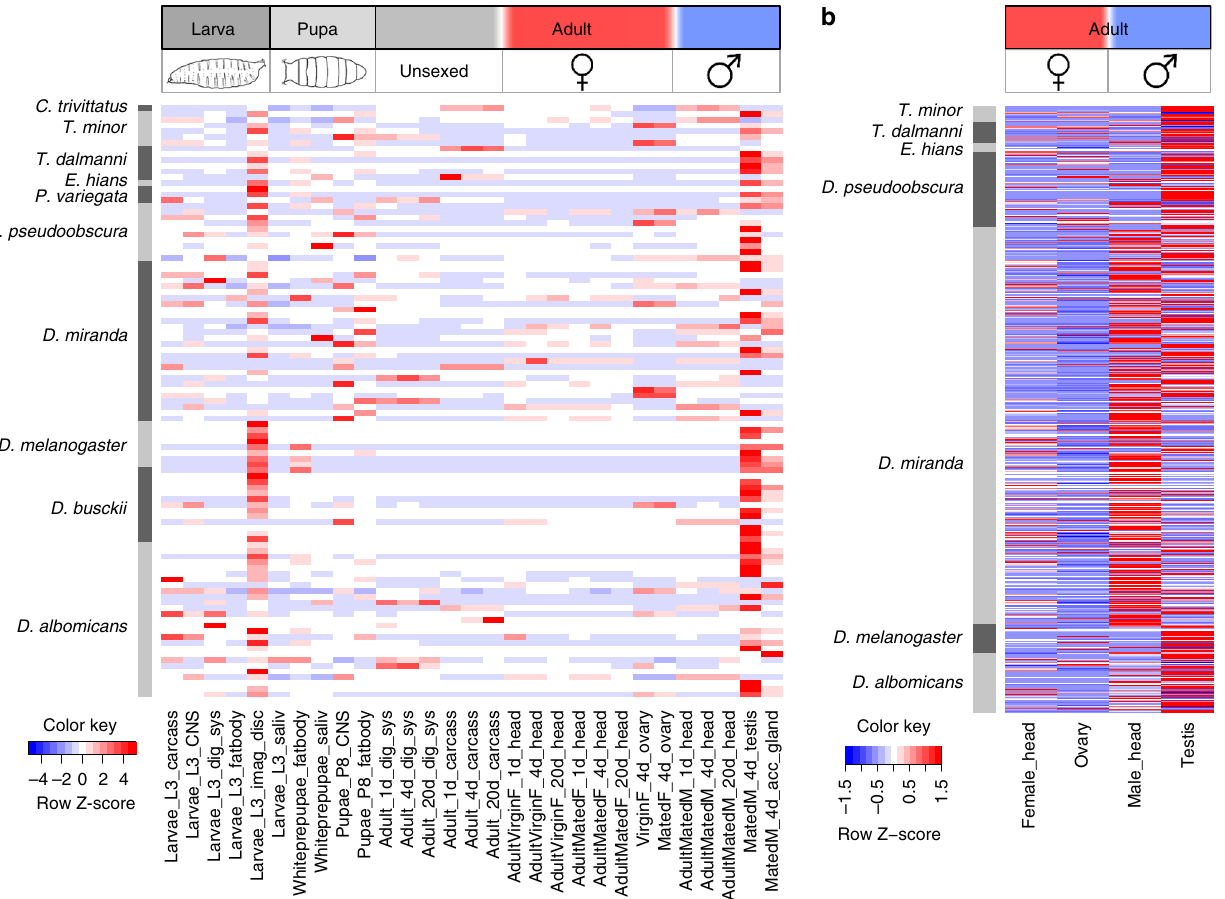
Fig. 6 Functional specialization of Y-linked genes in fl ies. a Expression patterns of putative Y-linked genes with homologs in D. melanogaster in multiple D. melanogaster tissues. b Expression patterns of putative Y-linked genes in male and female head, and testis and ovaries for different species. Expression values were calculated as TPM (transcript per million) and row normalized to obtain z -scores with a mean of 0 and standard deviation of 1, using the built-in scale = ’ row ’ argument in the heatmap.2 function from the package gplots in